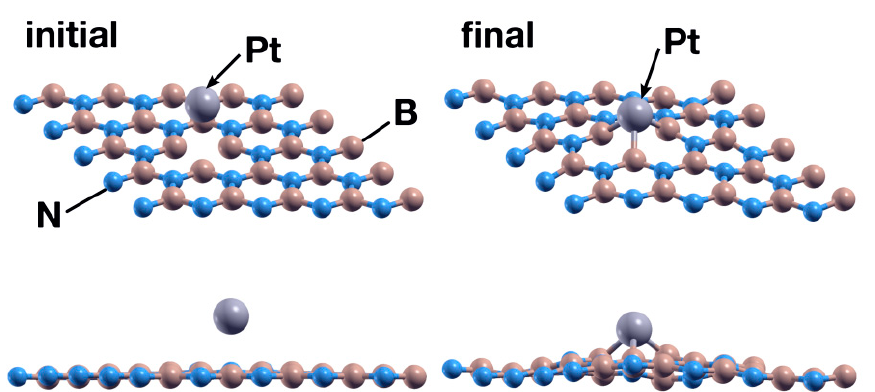
Figure 16. Initial ( left ) and final ( right ) configurations for the interaction of the hBN surface with an N vacancy and a Pt atom. The Pt atom is chemisorbed by the surface, just as it was in the hBN surface with a B vacancy.